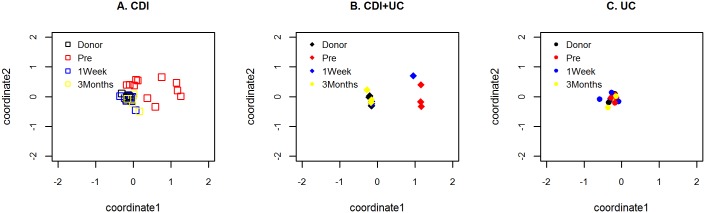
Principal coordinate analysis (PCoA) plots for Bray-Curtis distances (beta-diversity).(A) CDI-only recipient group: Donors (□), pre-FMT recipient (□), 1-wk. post-FMT recipient (□), 3-mos. post-FMT recipient (□); (B) CDI + UC recipient group: Donors (♦), pre-FMT recipient (♦), 1-wk. post-FMT recipient (♦), 3-mos. post-FMT recipient (♦); (C) UC-only recipient group: Donors (●), pre-FMT recipient (●), 1-wk. post-FMT recipient (●), 3-mos. post-FMT recipient (●).